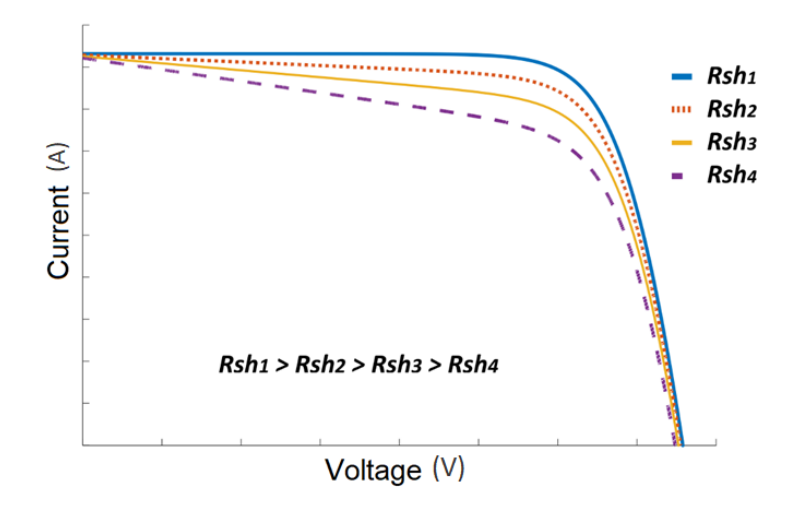
Figure 5. Effect of different shunt resistances ( R sh ) on the I-V curve of the cell [35].